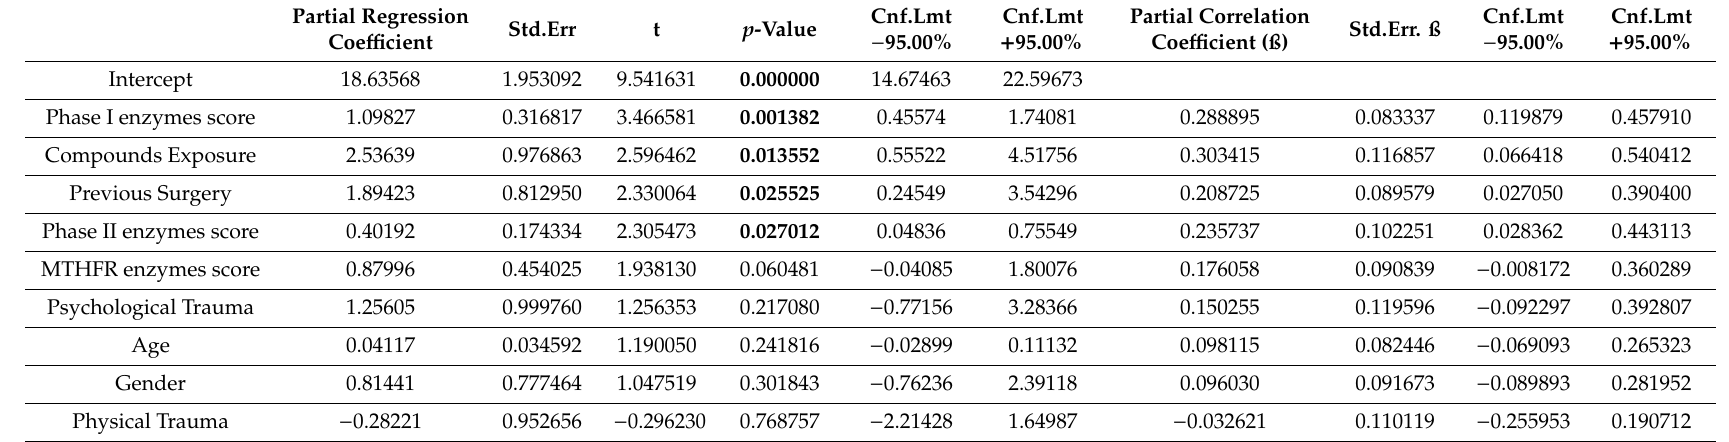
Legend: Table depicting the multiple regression model of the olfactory-related life quality (LQrv) in relation to genetic and clinical-anamnestic factors. MTHFR, folate cycle / methylation enzyme; Std., standard; Err, error; Cnf., confidence; Lmt, limit. In bold significant p